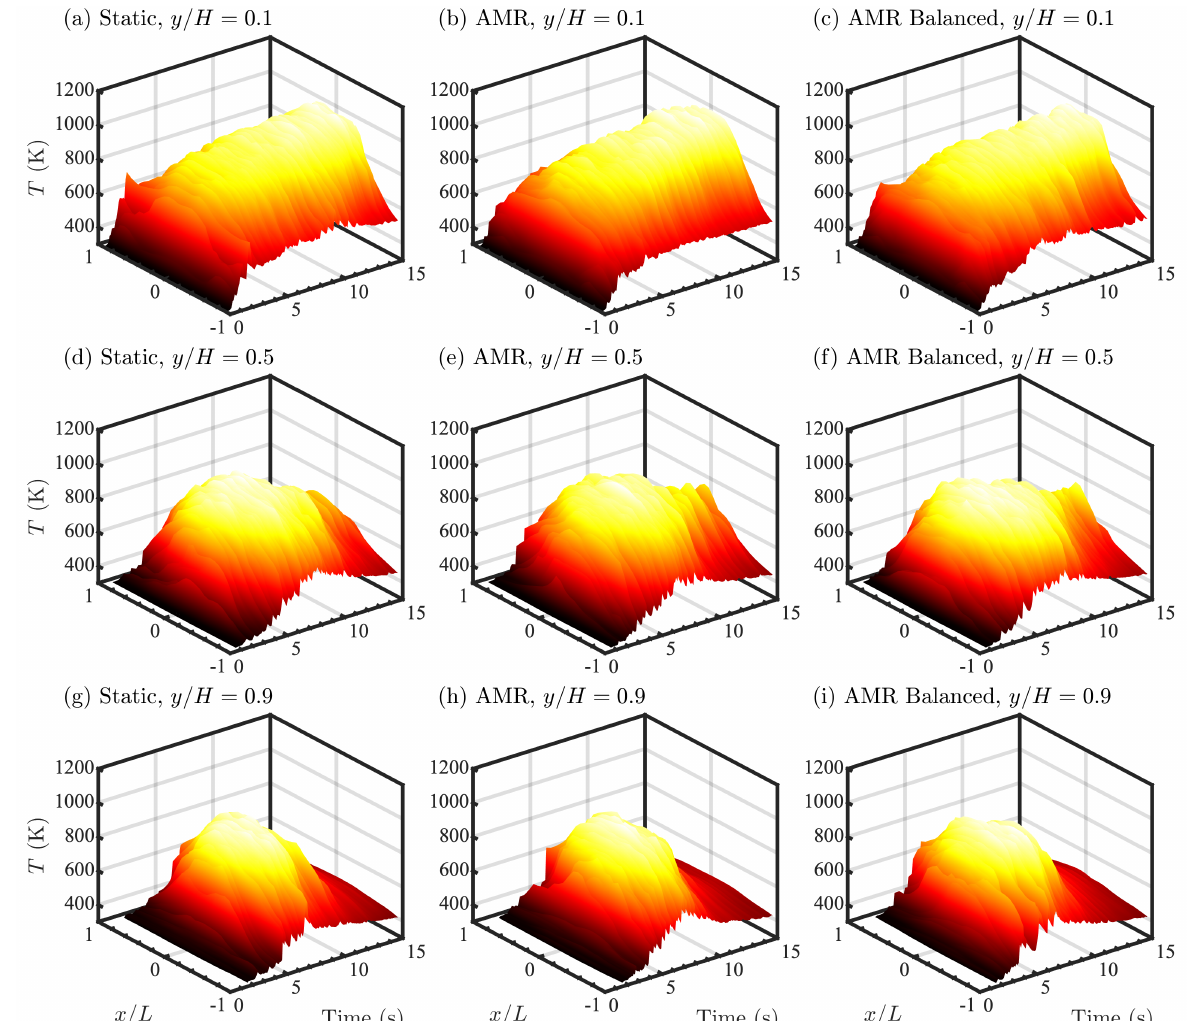
Figure 5. Time histories of gas-phase temperature across the panel, near the gas–solid interface, for the single panel vertical fire spread verification test case. Rows from top to bottom show time histories at panel heights of z / H = 0.1, 0.5, and 0.9, where H = 2.4 m is the total height and columns from left to right correspond to static, AMR, and balanced AMR cases, respectively. Temperatures are colored from low (black) to high (yellow). The transverse location x is normalized by the half panel width L = 0.3 m in all